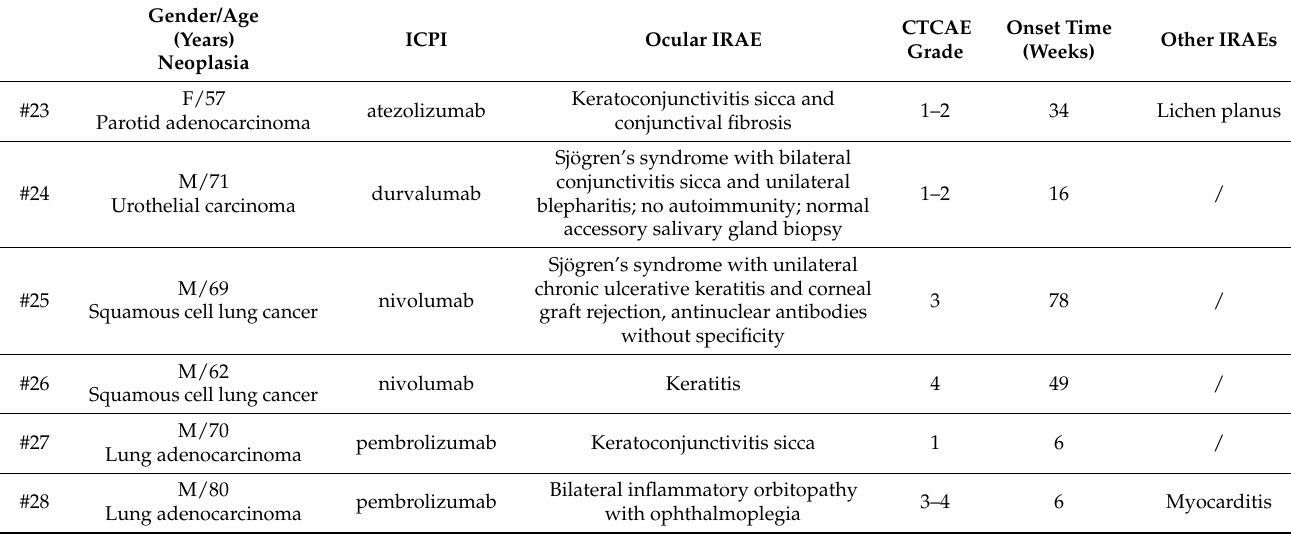
Table 4. Detailed description of non-uveitic ocular IRAEs.